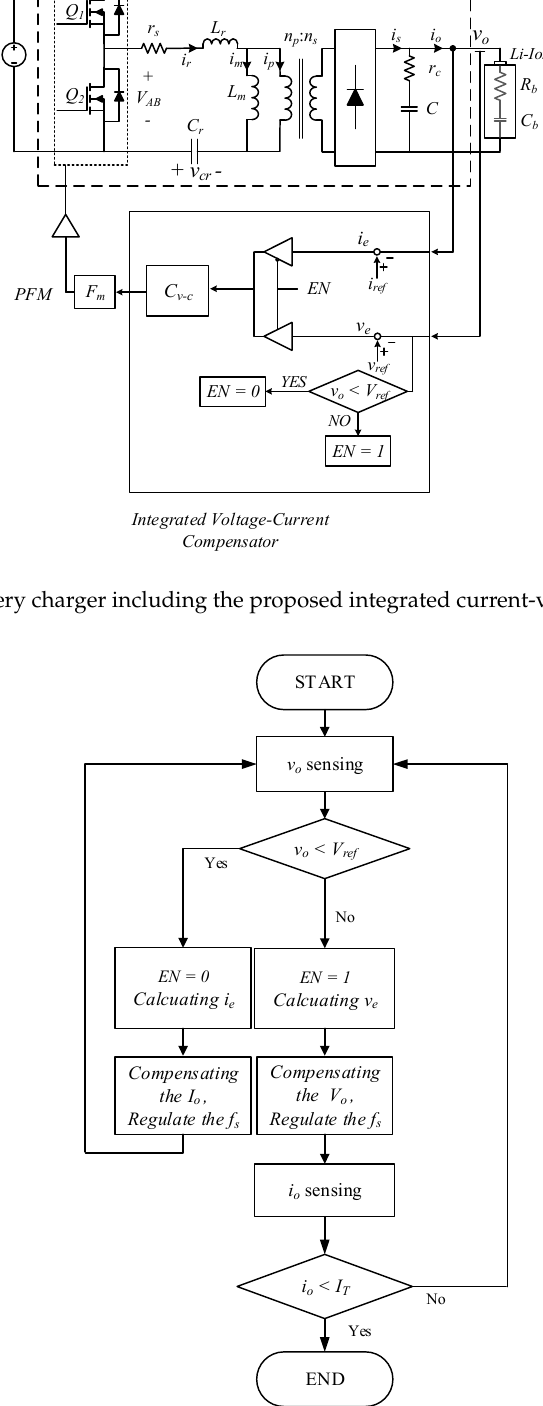
Table 1. Circuit parameters of the LLC resonant battery charger. Designator